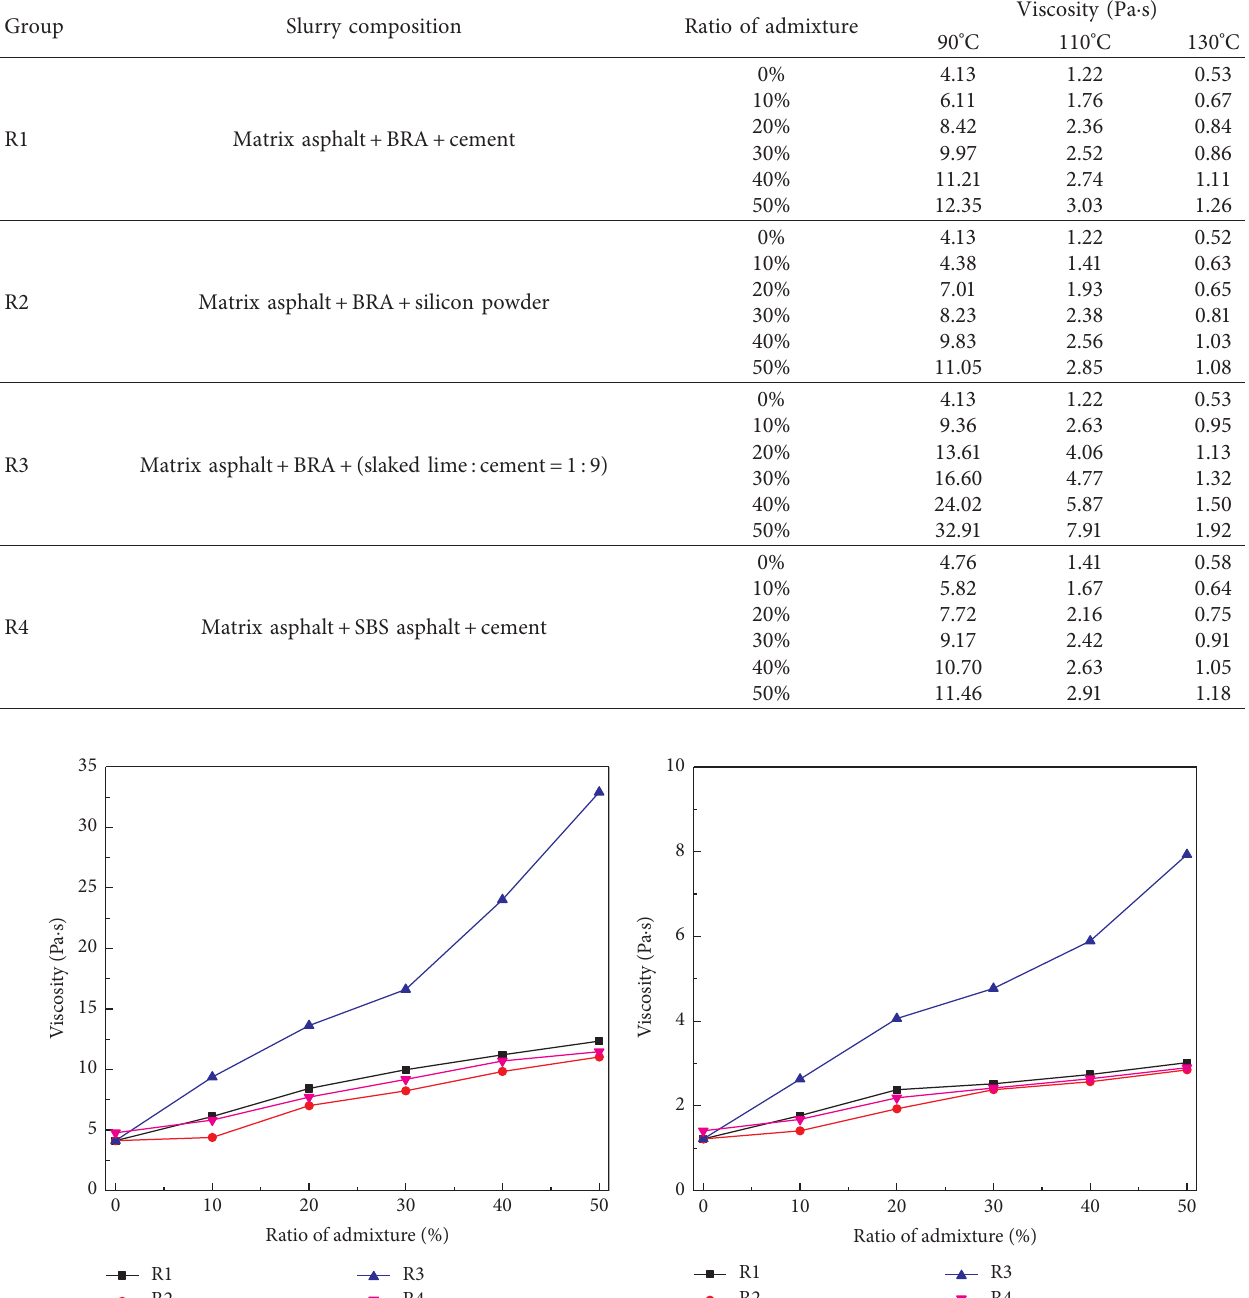
Table 11: Viscosity for asphalt-based grouting material with different ratios of admixture. Group Slurry composition